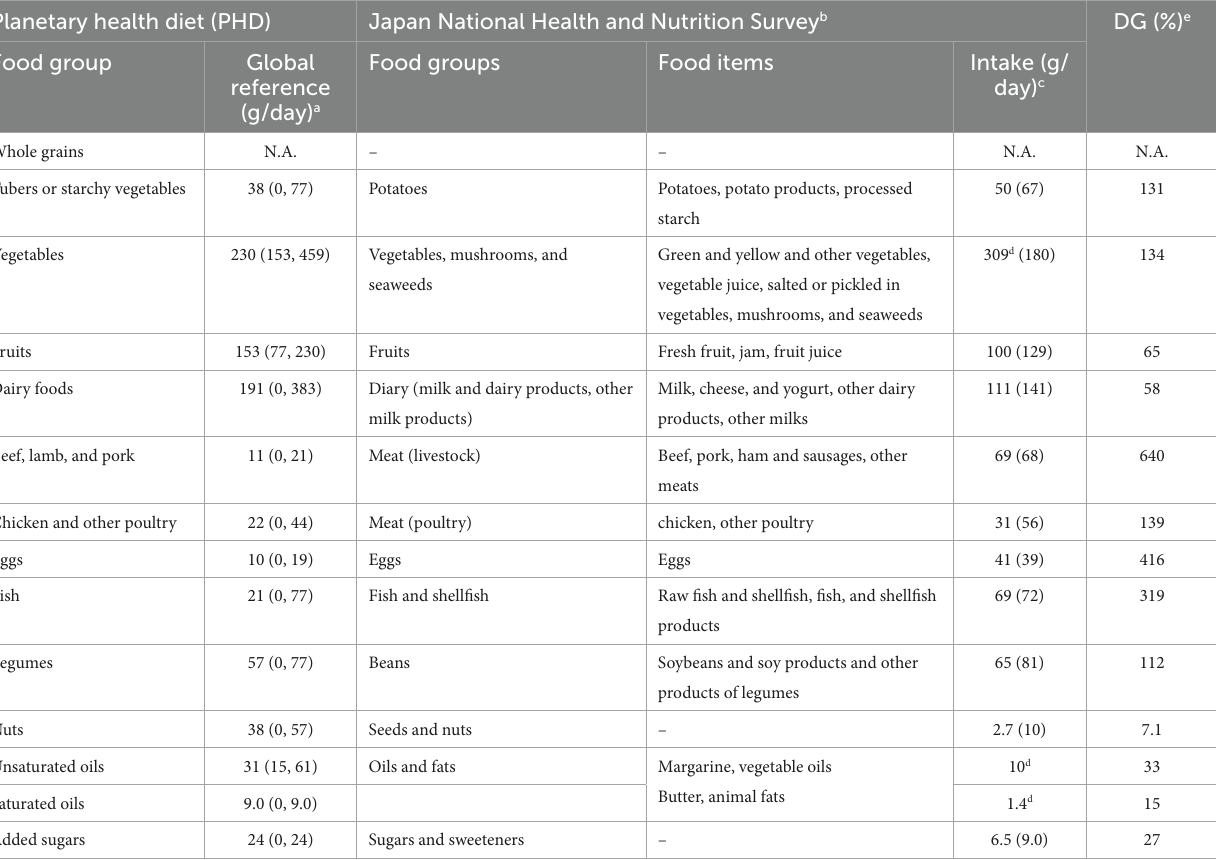
TABLE 1 Food group and dietary intake of National Health and Nutrition Survey, the global reference of the Planetary Health Diet and diet gap. Planetary health diet